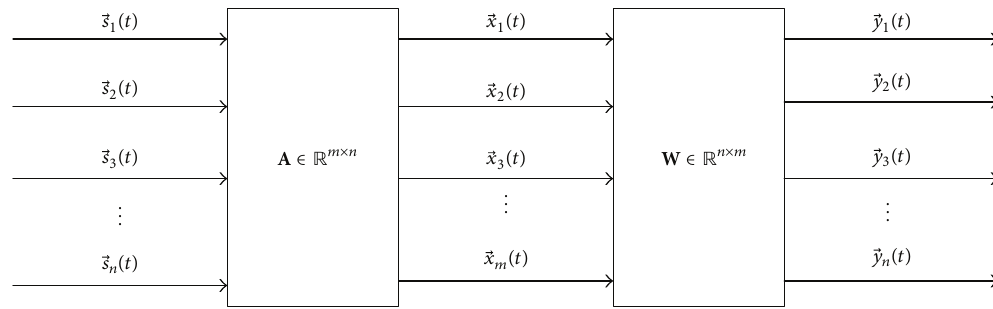
Figure 1: The essence of ICA method for BSS.